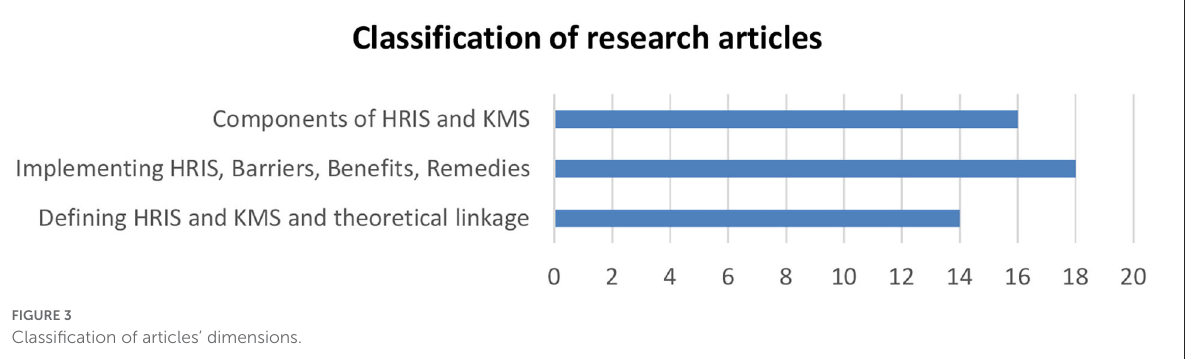
FIGURE3 Classification of articles’